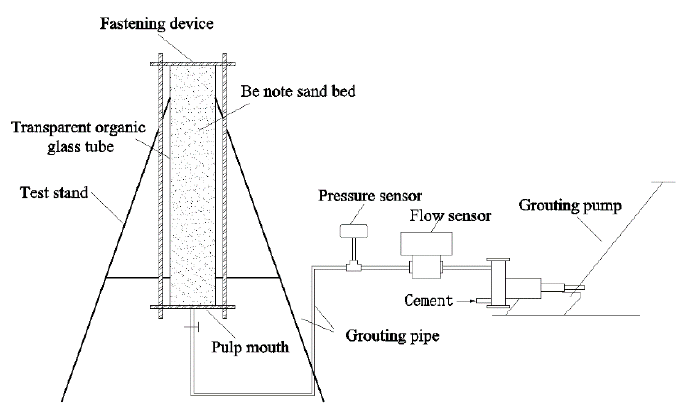
Figure 3. Penetration grouting test device.